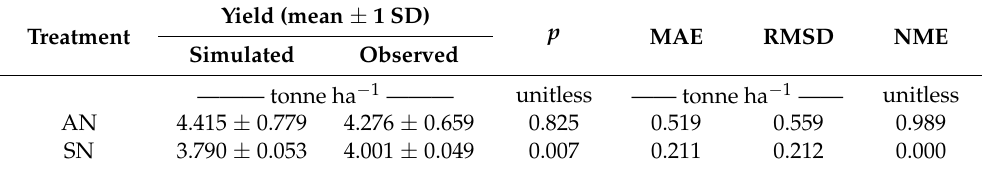
Table 5. Observed versus simulated barley grain yields for the different treatments in terms of the p -value shown by the t-test, the mean absolute error (MAE), the root mean squared deviation (RMSD), and normalised Nash–Sutcliffe model efficiency